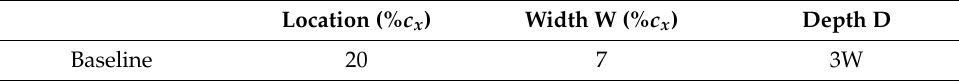
Table 1. Baseline Geometry